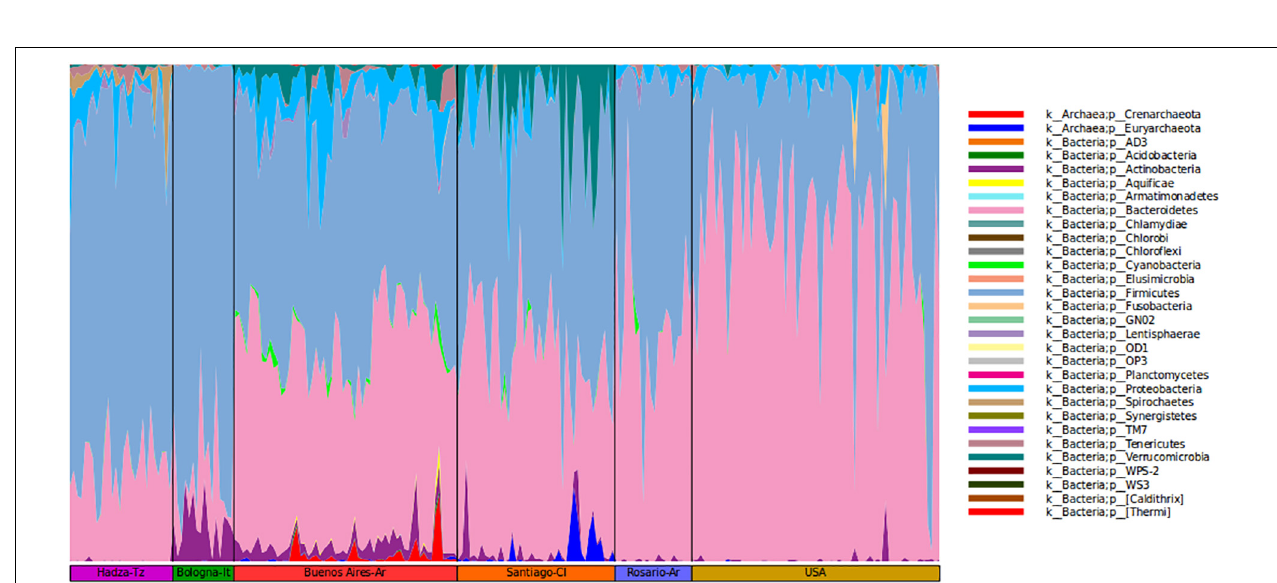
FIGURE 2 | Community composition of gut microbiome from each geographic location shown at the phylum level.